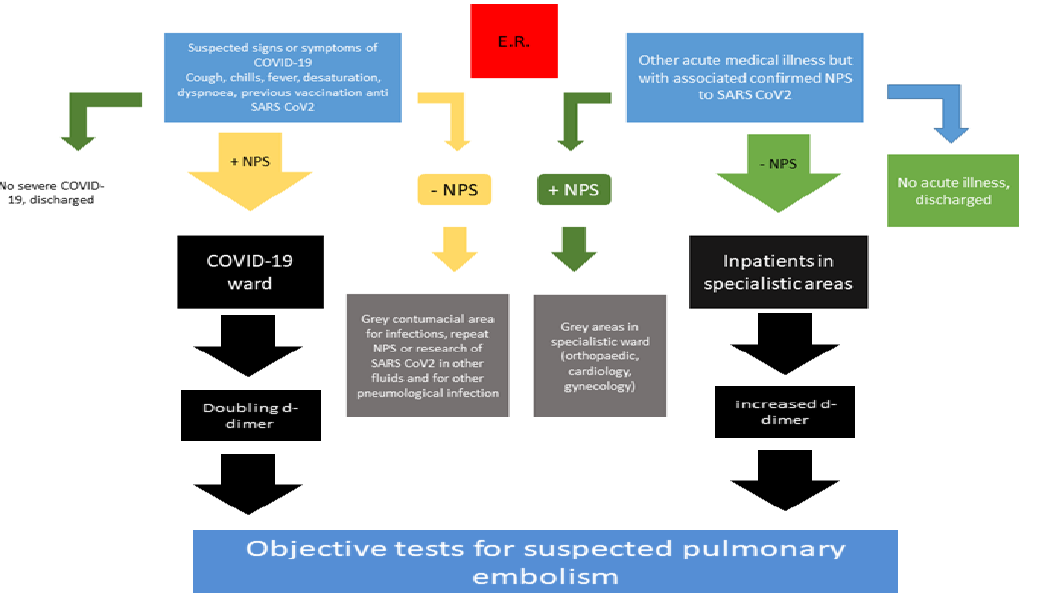
Figure 2. Updated flow chart for managing patients with confirmed COVID-19 and suspected pulmonary embolism, updated to summer/autumn 2022.